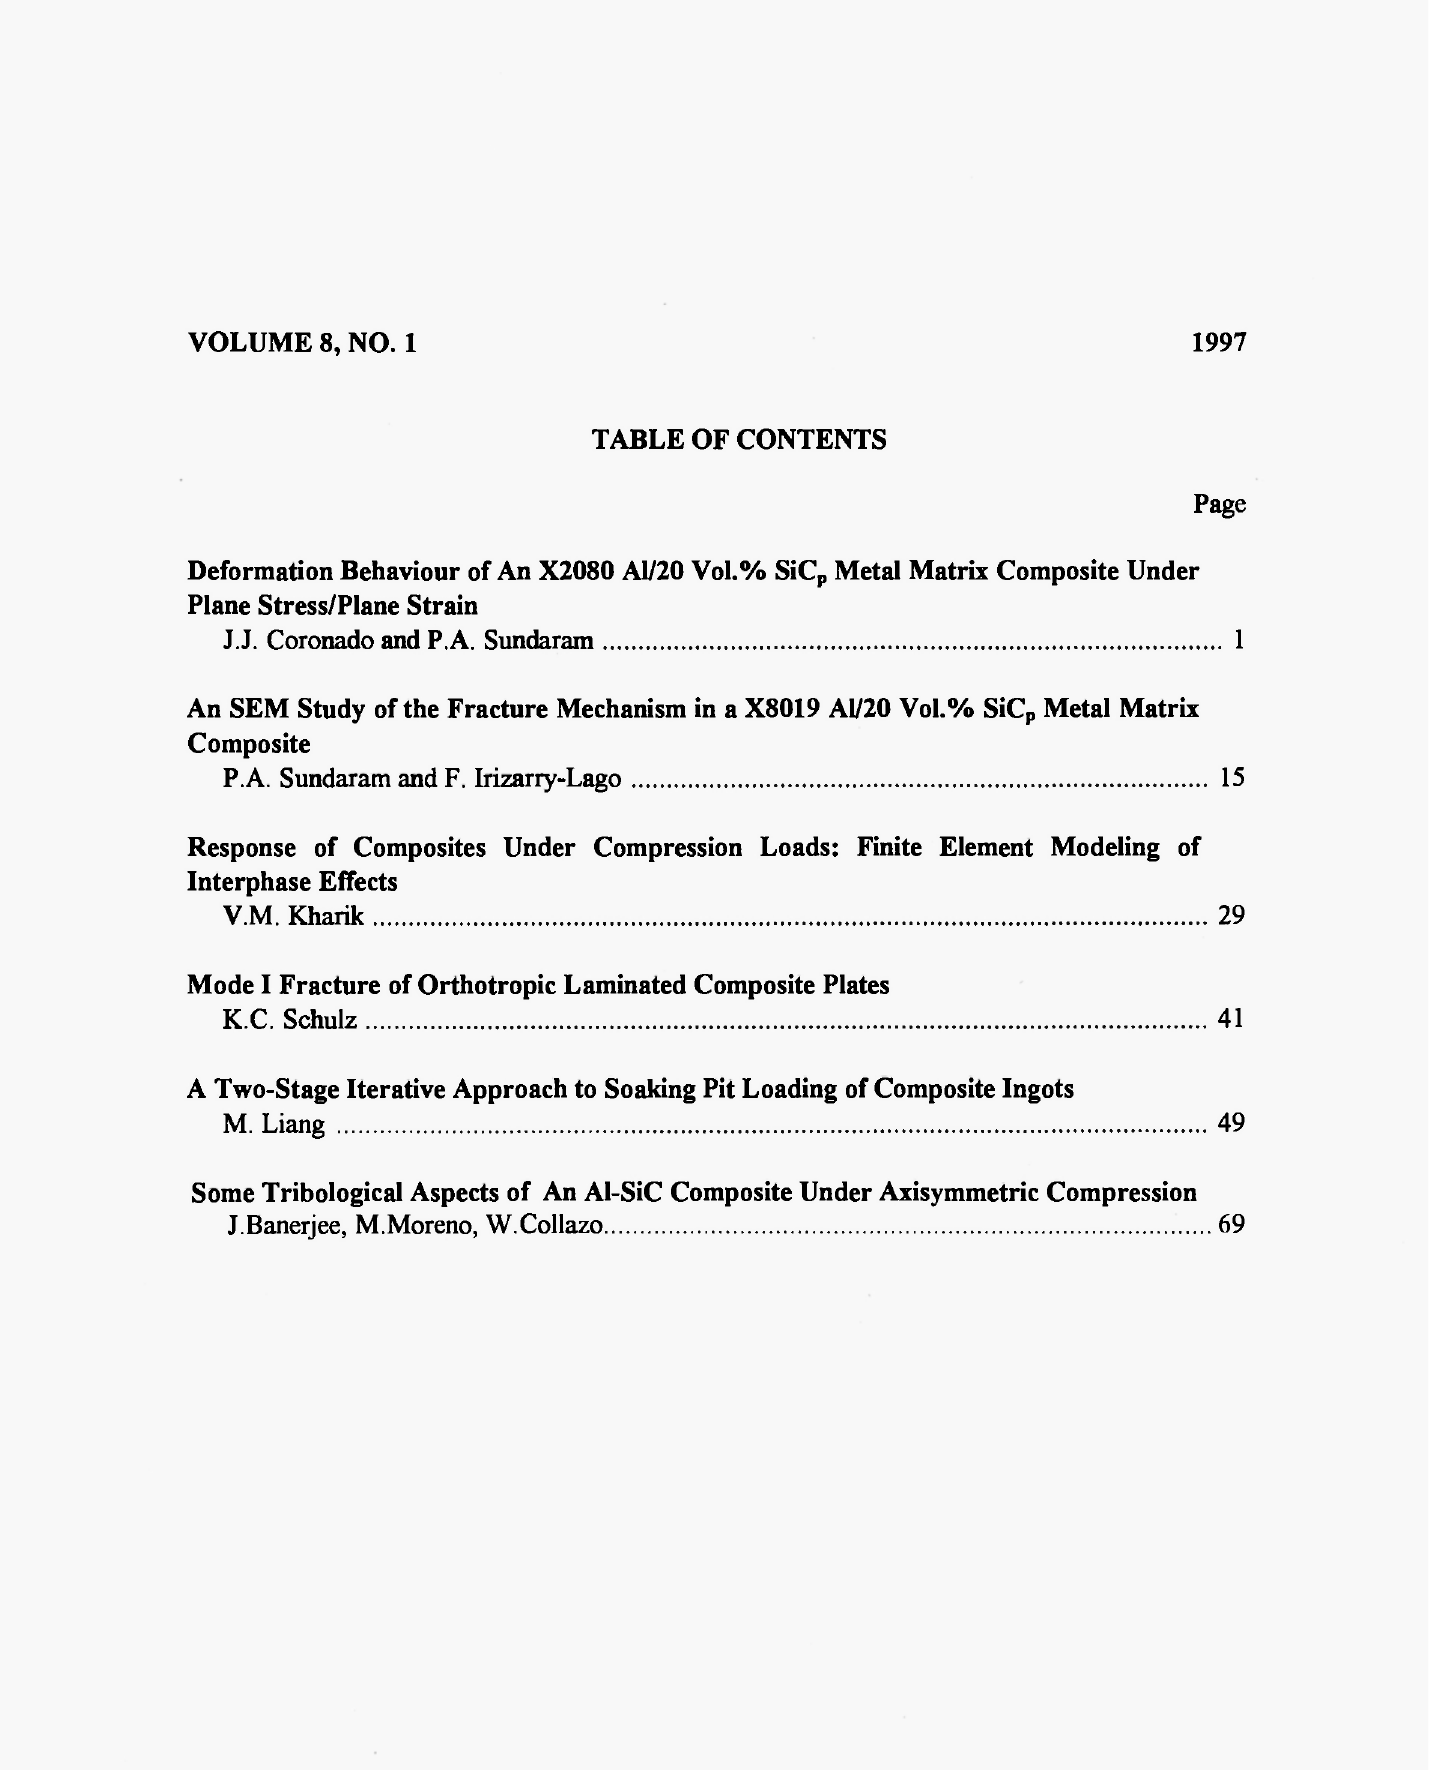
Metal Matrix Composite Under p